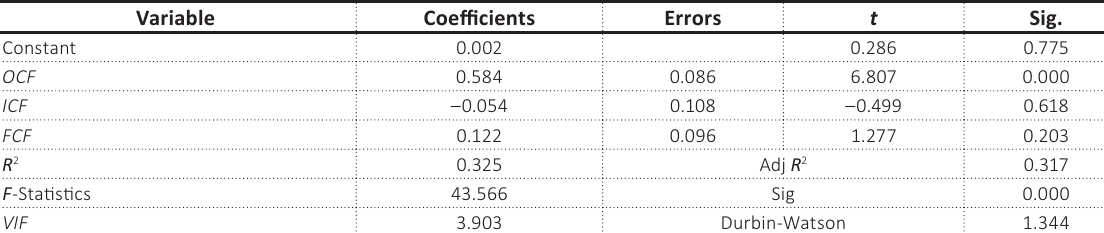
Table 7. OLS regression results (short operating cycle